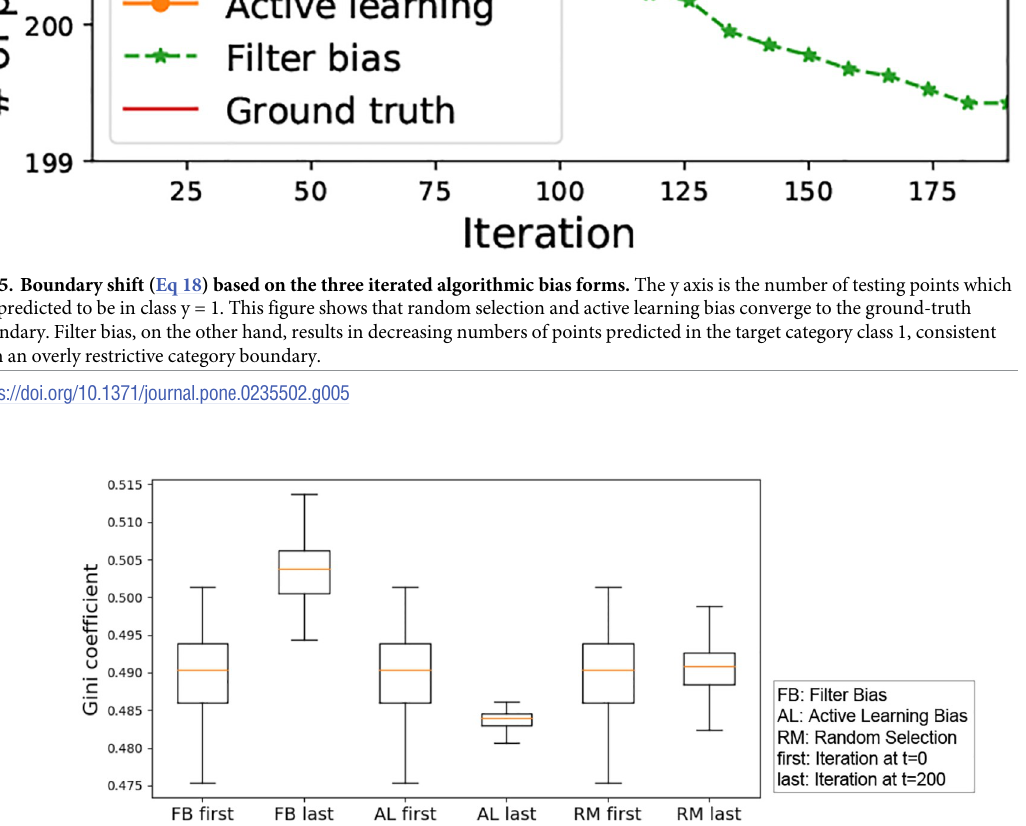
PLOS ONE | https://doi.org/10.1371/journal.pone.0235502 August 13,